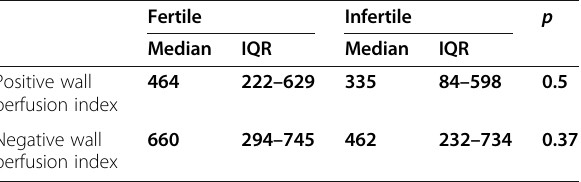
Table 3 Perfusion indices in the positive and negative walls in the two subgroups of fibroid patients (fertile and infertile) Fertile